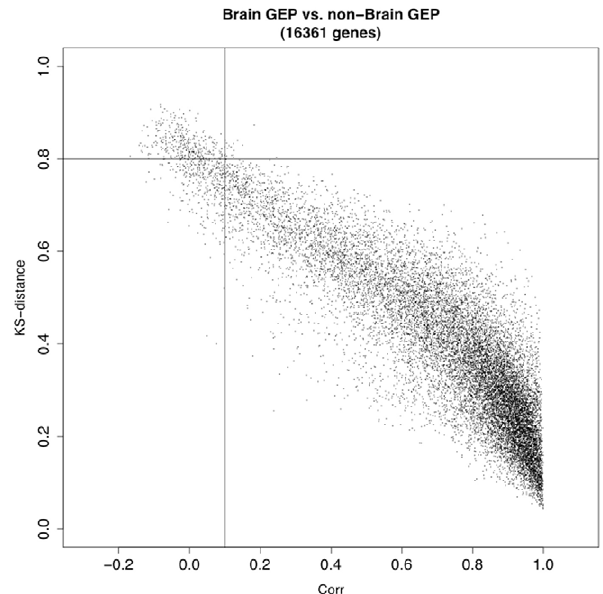
Figure 6. KS__d vs. Corr values for all GEPs. The horizontal line represents the cutoff KS_d . 0.8; the vertical line represents the cutoff Corr , 0.1. Potential biomarkers are in the box at upper left. Similar figures for lung, liver, embryo, heart, and small intestine are in File S1 .